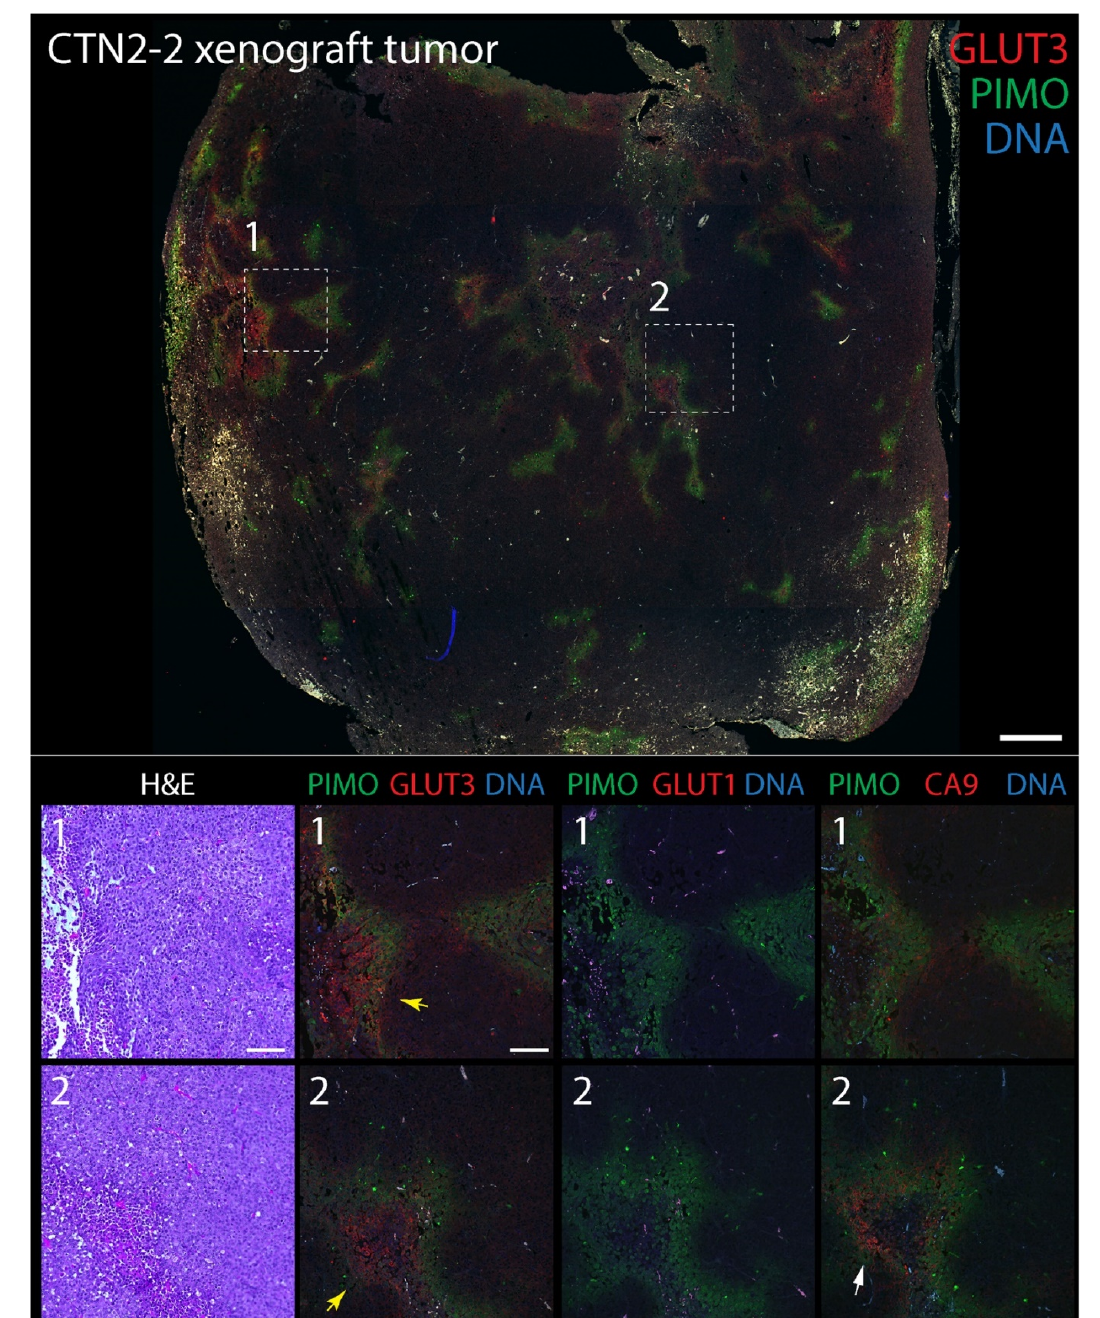
Figure 3. GLUT3 co-localizes with pimonidazole (Hypoxyprobe) in mouse xenograft tumors formed from prostate epithelial CTN-2-2 cells. Non-tumorigenic immortalized prostate epithelial PrEC-Hahn cells were transformed by transiently inducing chromosomal instability. The resulting tumorigenic line was named CTN-9, which produced malignant solid xenograft tumors in subcutaneously injected NSG mice [52]. Cell lines isolated from these tumors were named CTN1-2 and 2-2 lines [52]. (Upper panel) Single tumor section stained for pimonidazole (PIMO) (green) and GLUT3 (red). DNA, blue. Boxed regions are shown at higher magnification in the lower panels. (Lower panels) Higher magnification images from boxed regions 1 or 2 in upper panel. Serial tissue sections were stained for hematoxylin and eosin (H&E), PIMO (green), and GLUT3, GLUT1 or CA9 (red) as indicated. Concentrations of GLUT3 (yellow arrows) and CA9 (white arrows) that juxtapose with PIMO are marked. Dashed white boxes show GLUT3 concentrated at the plasma membrane in tumor cells (insets). Scale, 100 µ